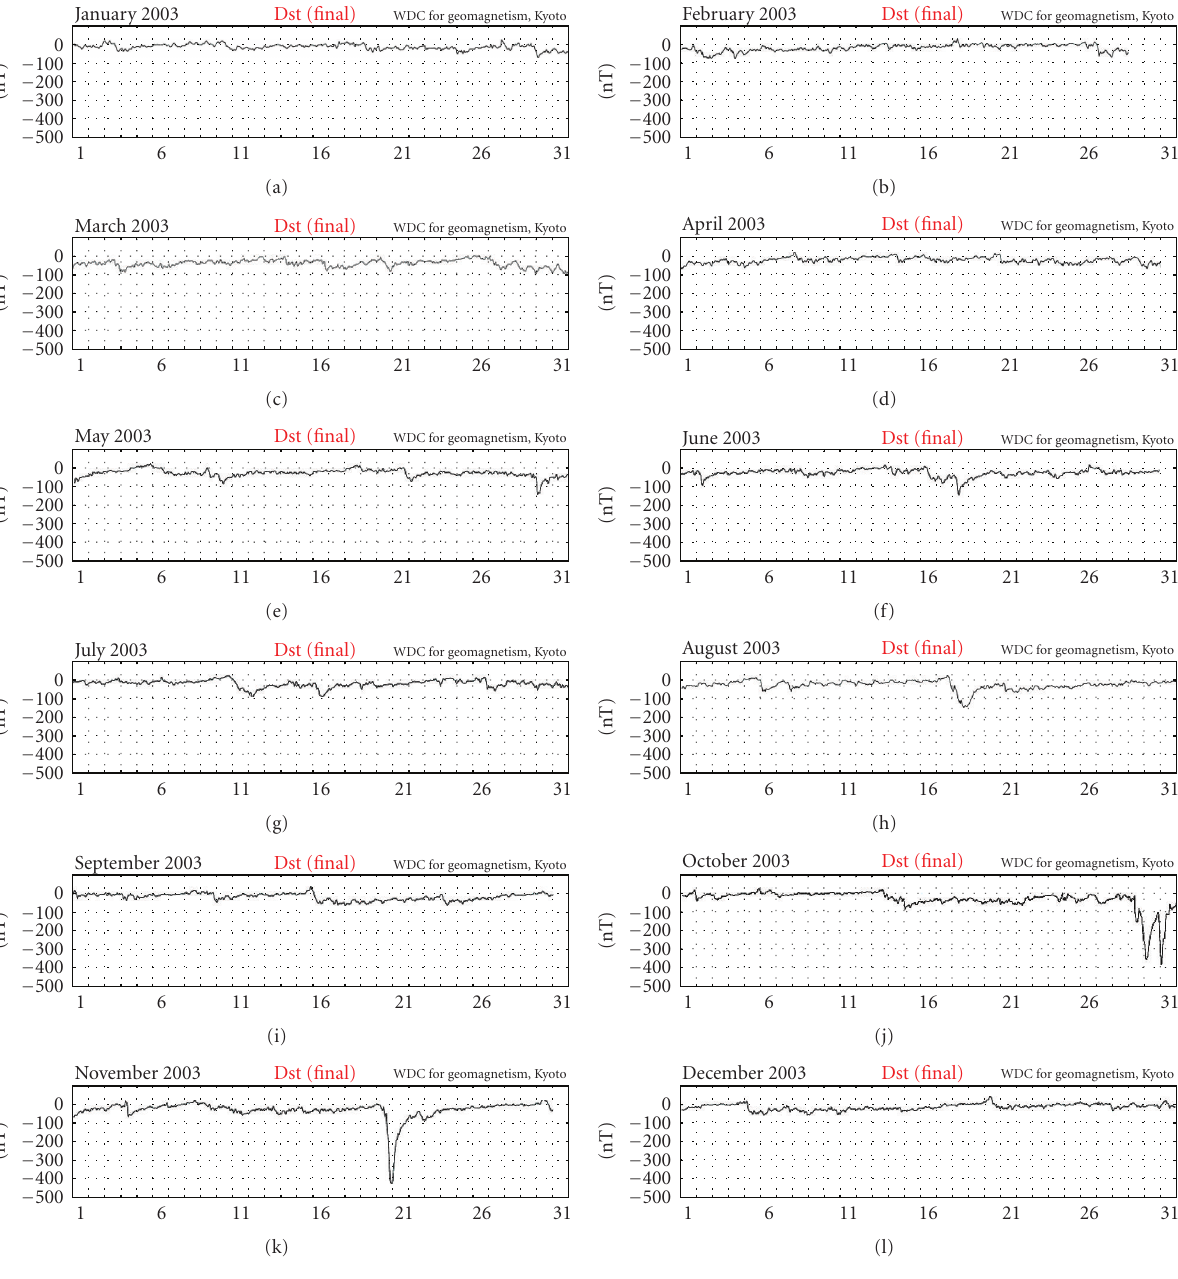
Figure 8: This figure denotes the Dst indices for year 2003 in